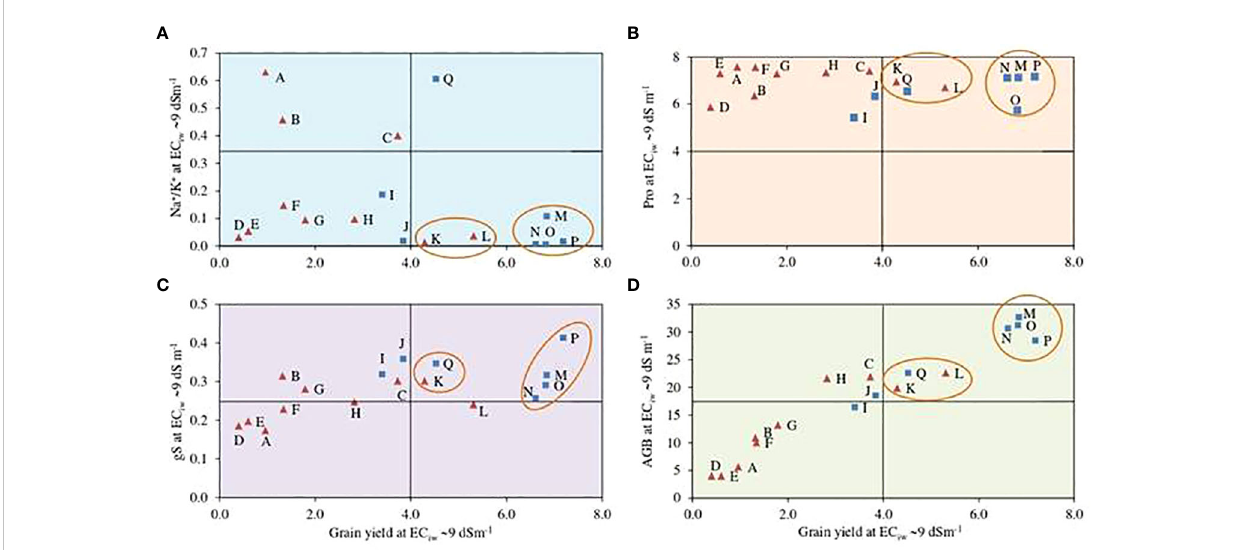
FIGURE 2 Biplots representing the interaction of important physiological traits; (A) sodium to potassium (Na + /K + ) ratio, (B) proline content (Pro; mg g -1 ), (D) above ground biomass (AGB; g plant -1 ) and (C) stomatal condcutance (gS; mol m -2 s -1 ) with grain yield (GY; g plant -1 ) of pearl millet hybrids (blue ☐ ) and inbred lines (red Δ ) at EC iw -99 dSm -1 . Data represents mean value of 15 pooled measurements (3 plants per pot x 5 replications); A: HMS 47A; B: ICMA 95222; C: ICMA 971ll; D: HTP 94/54; E: HBL 11; F: HMS 7A; G: AC04-13; H: ICMA 843-22; I: ICMA 94555; J: H77/833-2-202; K: HHB 67 Improved; L: HHB 226; M: HHB 234; N: HHB 223; O: HHB 272; P: HHB 146; Q: HHB